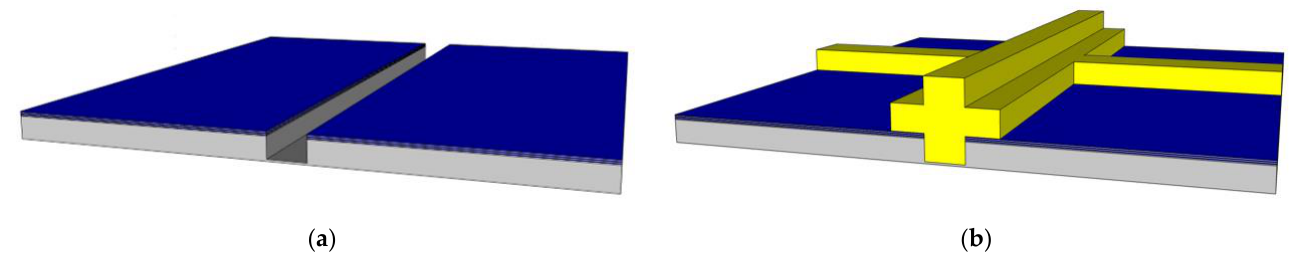
Figure 5. Modified steps for a 3DHF device: ( a ) A trench is etched into the substrate bulk; ( b ) SU8 photoresist is layered and developed in a two-step process. The first SU8 layer fills the trench and covers the substrate. This layer will be patterned and developed to leave the channel core and most of the buffer inlet cores. The second step places another layer on the device, which is patterned and developed to leave a raised rectangular structure over the trench.